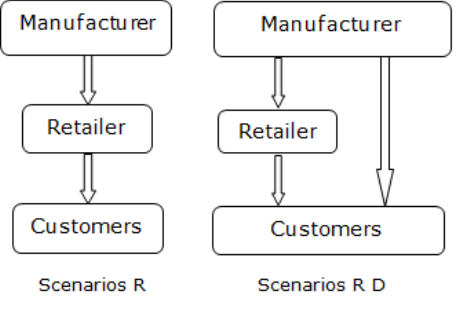
Figure 1. The supply chain structure of Scenarios R,